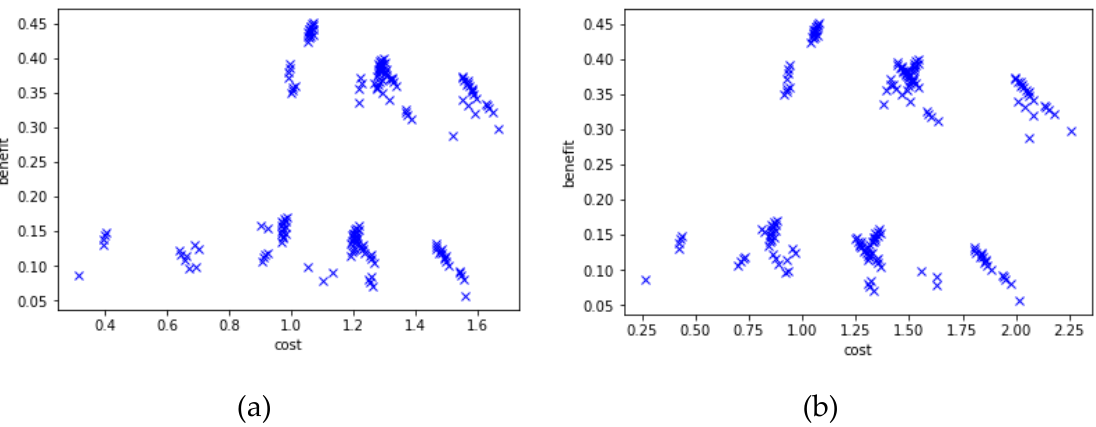
Figure 6. Pre-defined scheme 3 (energy generation through renewables) ( a ) and pre-defined scheme 3A (energy generation through renewables + economic aspects) ( b ).